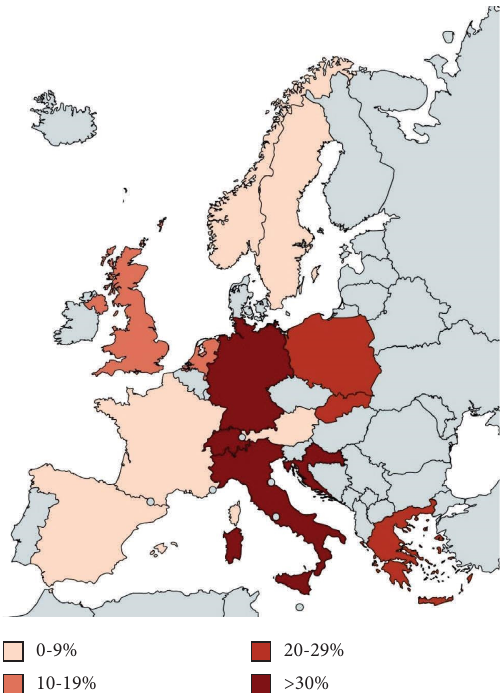
Figure 2: Seroprevalence of anti- B. henselae antibodies in European countries based on studies from 1950 to 2022.